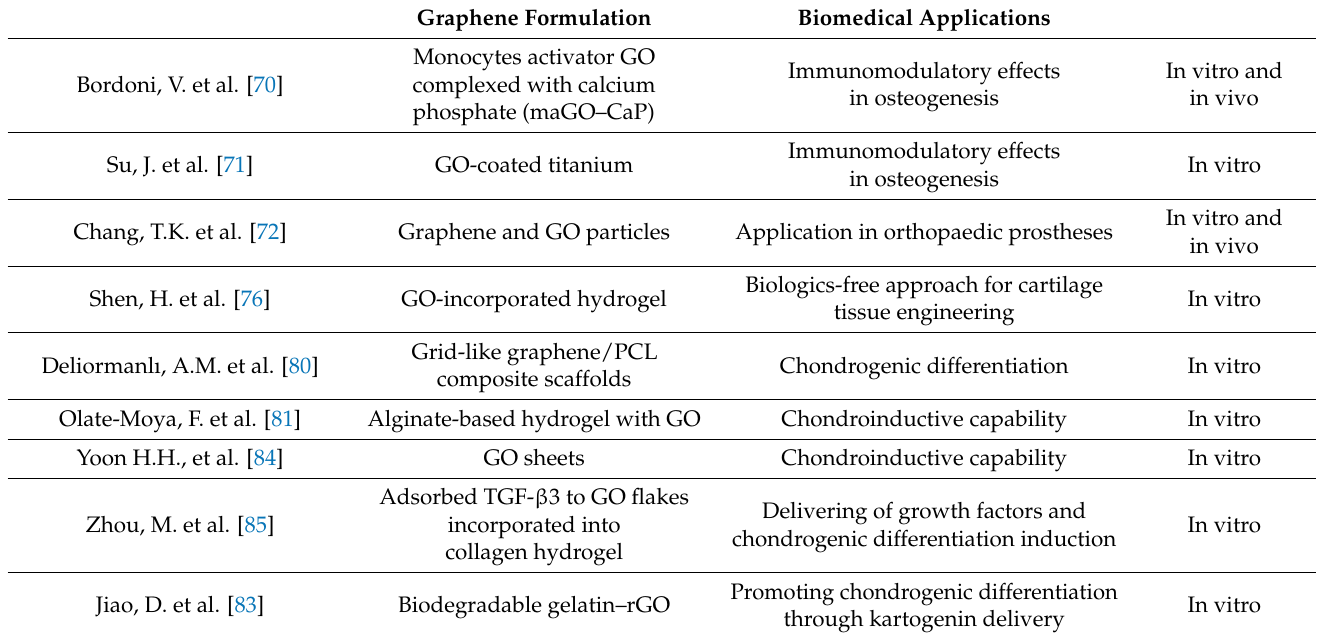
Table 3. Biomedical applications of GO. The table summarizes in vitro and in vivo studies related to GO and